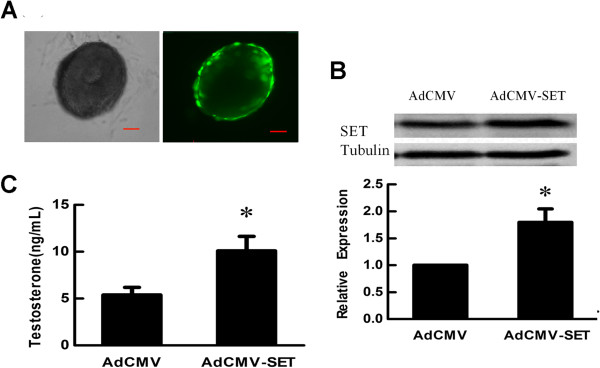
Effect of SET overexpression on testosterone synthesis in theca cells. (A) Infection of follicular theca cells with recombinant adenoviruses. Follicles were infected with recombinant adenovirus AdCMV-SET or AdCMV and cultured for 24 h. Over 90% theca cells were infected as judged by the expression of GFP under a fluorescence microscope. Left: light microscope; right: fluorescence microscope (Scale bar = 50 μm). (B) Western blot analysis of SET protein expression in follicles infected with recombinant AdCMV-SET adenovirus for 48 h. SET protein level in the follicles infected with AdCMV-SET were increased 1.8 times when compared with that in follicles infected with AdCMV. Tubulin was used as internal controls. (C) Effect of SET overexpression on testosterone synthesis in theca cells. Follicles were infected with AdCMV-SET or AdCMV for 48 h. Compared with that in the AdCMV infection group, testosterone production in the culture media of the AdCMV-SET infection follicles was significantly increased. Results are presented as Mean ± SD from at least 3 independent experiments. *, p < 0.05 compare with AdCMV.